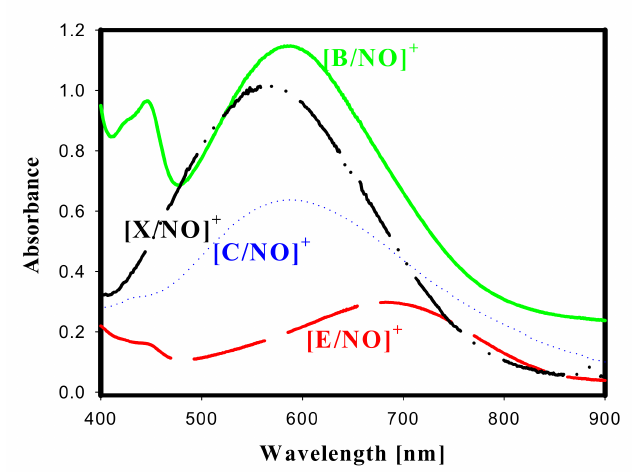
Figure 8. UV-vis spectra of [ B /NO] + ( λ max = 590 nm; solid line), [ C /NO] + ( λ max = 590 nm; dotted line), [ E /NO] + ( λ max = 690 nm; medium dashed line), and [ X /NO] + ( λ max =569 nm; dashed dot-dot line) in dichloromethane using either neutral calixarene donor/NO + or calixarene cation